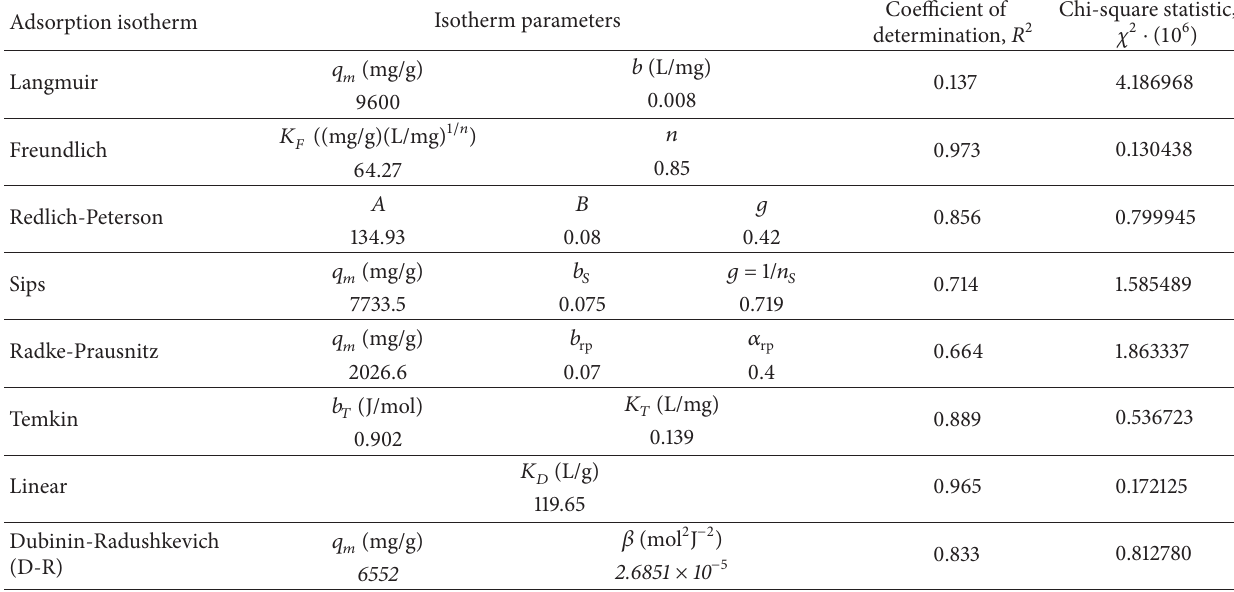
Table 2: Summary table of the equilibrium isotherm parameters for the adsorption of pyrethrin onto SDS micellar flocs. Adsorption